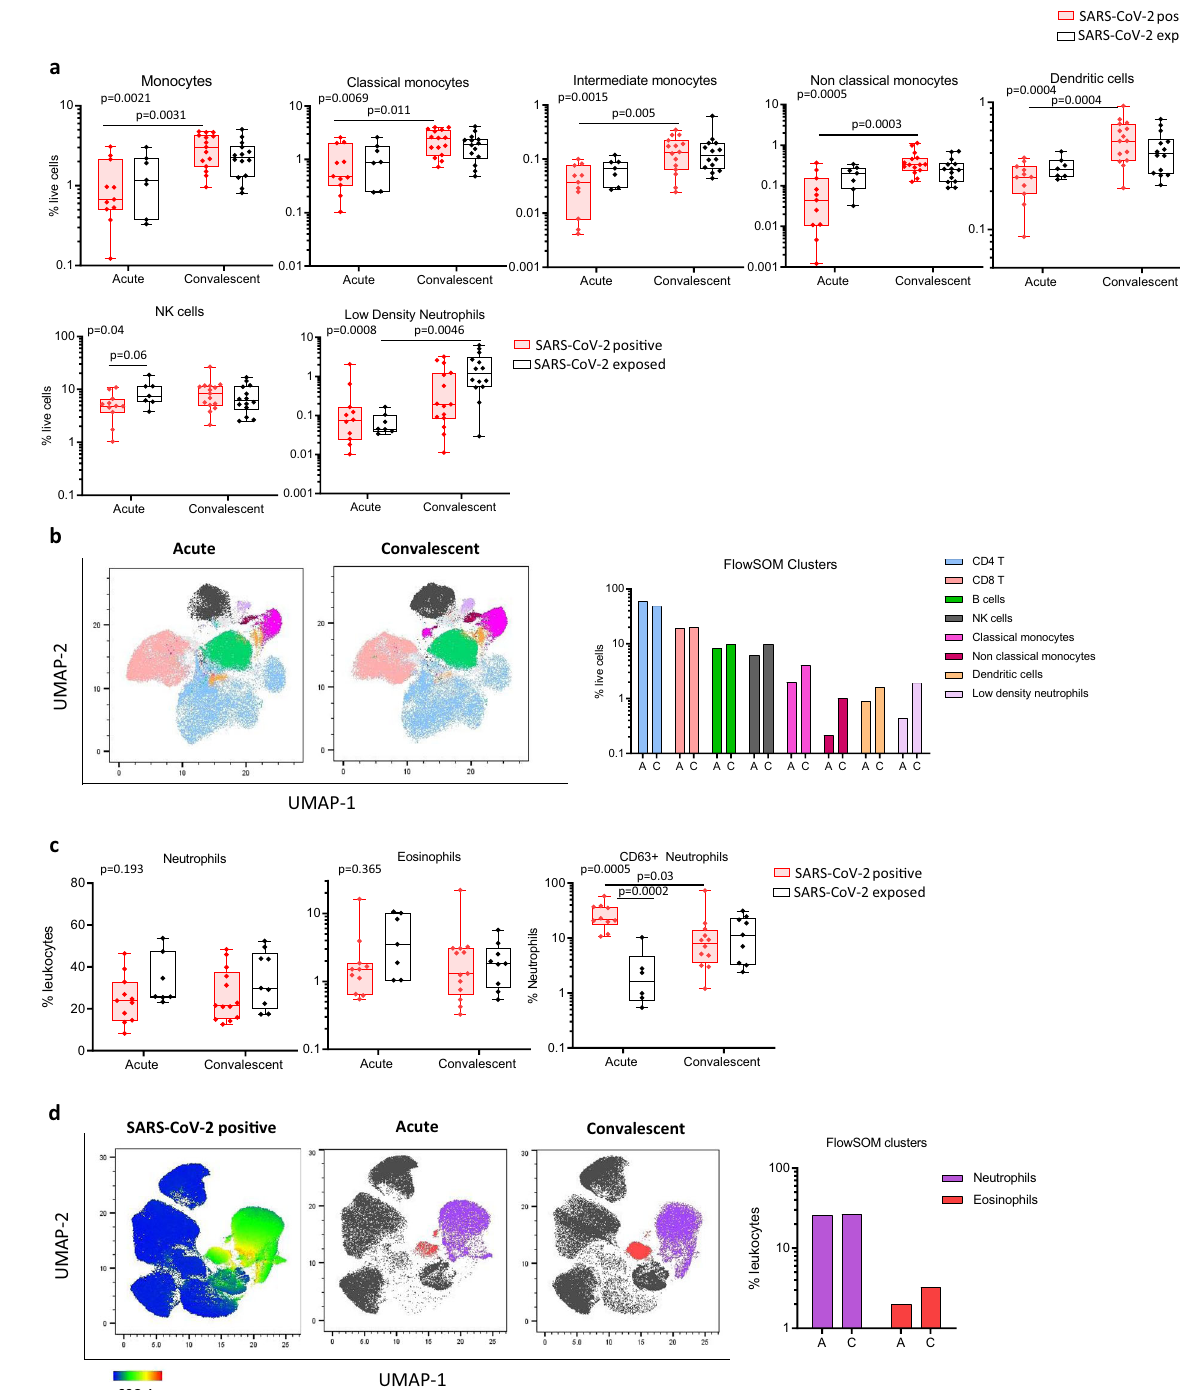
Fig. 1 Innate cell pro fi les of children infected with or exposed to SARS-CoV-2 during the acute and convalescent phase. a Frequency of monocytes and subsets (classical, non-classical, intermediate), dendritic cells, NK cells and low-density immature neutrophils in PBMC samples of children during infection (SARS-CoV-2 positive n = 11, SARS-CoV-2 exposed n = 7) and in convalescence (SARS-CoV-2 positive n = 16, SARS-CoV-2 exposed n = 14). b Hierarchical clustering was performed on PBMC samples using FlowSOM and projected onto a UMAP plot. Frequencies of clusters corresponding to CD4 T, CD8 T, B cells, NK cells, classical monocytes, non-classical monocytes, dendritic cells and low-density neutrophils during acute (A) and convalescent (C) phase are reported. c Frequency of neutrophils and eosinophils in fresh whole blood (SARS-CoV-2 positive n = 11, SARS-CoV-2 exposed n = 7) and in convalescence (SARS-CoV-2 positive n = 13, SARS-CoV-2 exposed n = 9). Neutrophils were assessed for expression of activation marker CD63 (SARS- CoV-2 positive n = 11, SARS-CoV-2 exposed n = 6) and in convalescence (SARS-CoV-2 positive n = 13, SARS-CoV-2 exposed n = 9). d Hierarchical clustering was done on whole blood samples using FlowSOM and projected onto a UMAP plot, coloured by intensity of SSC-A expression in the fi rst plot, and then by annotated granulocyte cell population. Frequencies of clusters corresponding to neutrophils and eosinophils are reported. P values by Kruskal- Wallis rank sum test and Dunn ’ s multiple comparison testing. All statistical tests were performed two-sided. Boxplots show the medians, the 1st and 3rd quartile as well as the smallest and largest values as